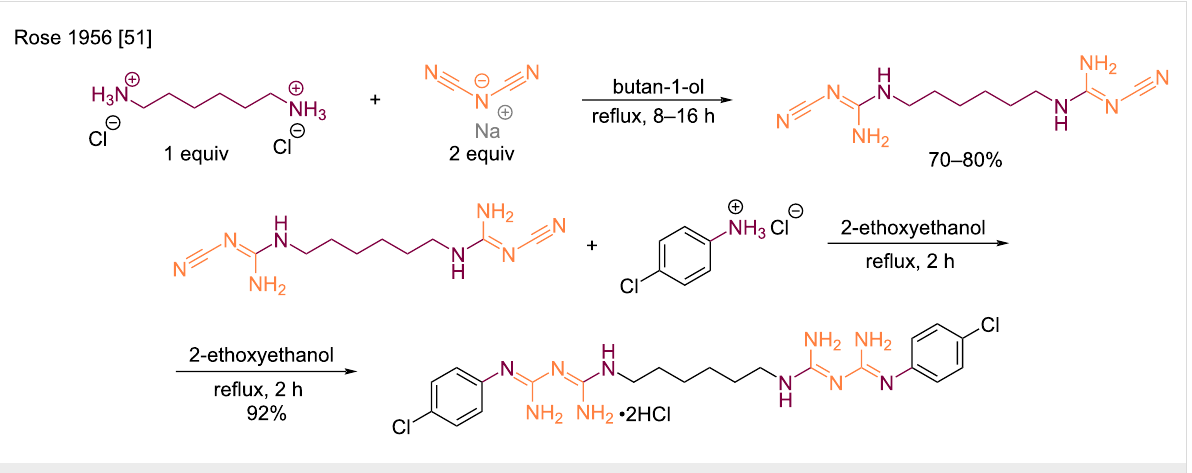
Scheme 21: Example of industrial synthesis of chlorhexidine